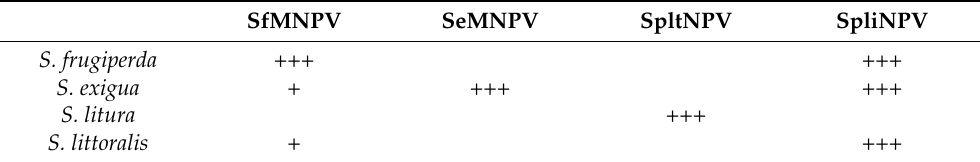
Table 2. Host specificity of Spodoptera spp. baculoviruses found in the genus Alphabaculovirus [61,63,69–71]. SfMNPV SeMNPV SpltNPV SpliNPV S. frugiperda +++ +++ S.